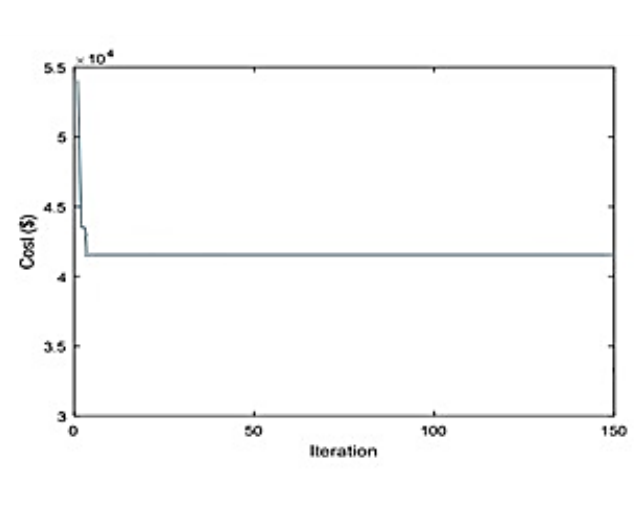
Figure 5. Settlement Cost at a Rate of